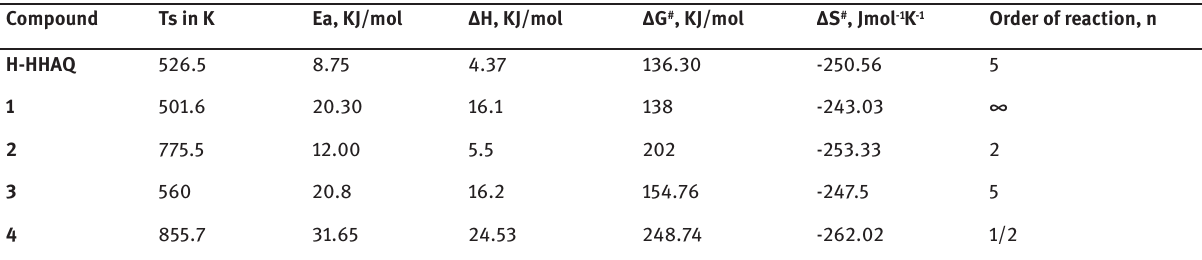
Table 5: Kinetic and thermodynamic parameters of H-HHAQ and its metal complexes. Compound